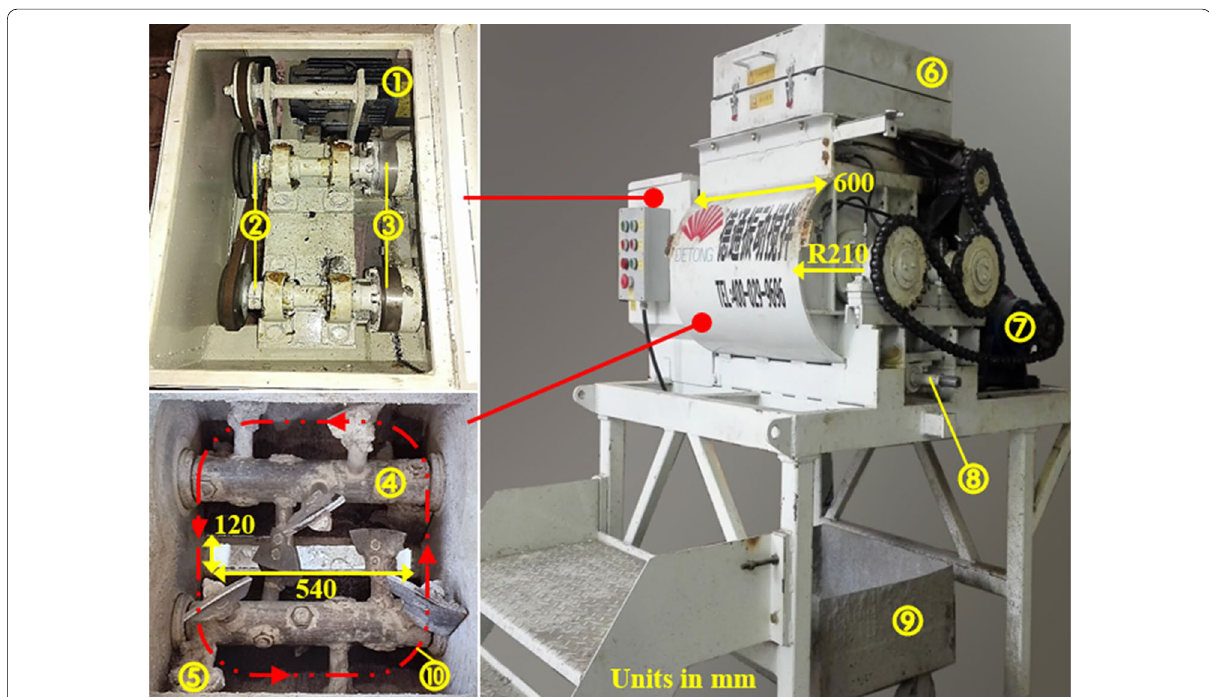
Fig. 2 Vibration mixer. (1) vibration driving motor; (2) vibration transmission shaft; (3) eccentric connecting device; (4) mixing shaft; (5) mixing blade; (6) top cover; (7) mixing driving motor; (8) discharging gate; (9) mixed material container; (10) axial circulation of the